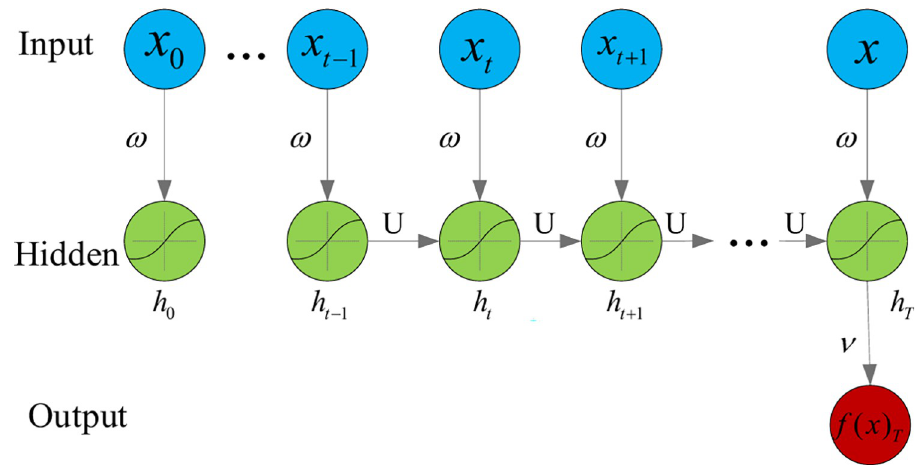
Fig 2. Basic recurrent neural network (RNN)